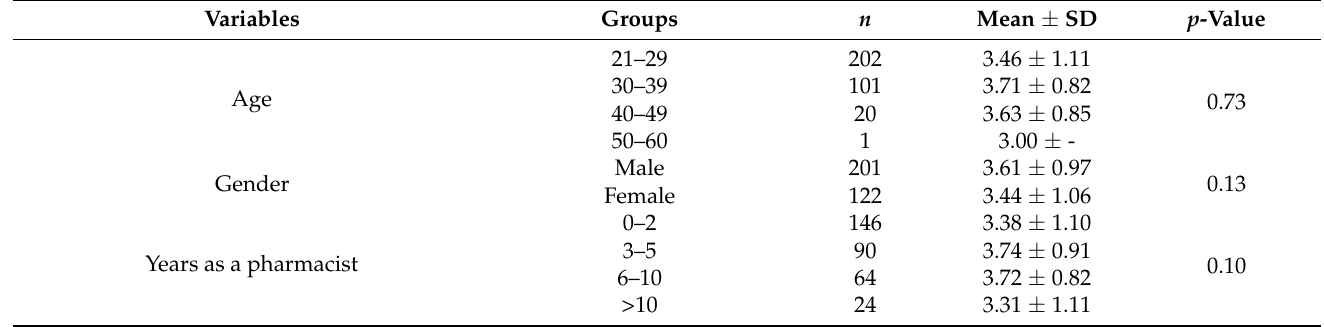
Table 4. Distribution of perceived practice of anemia according to socio-demographic